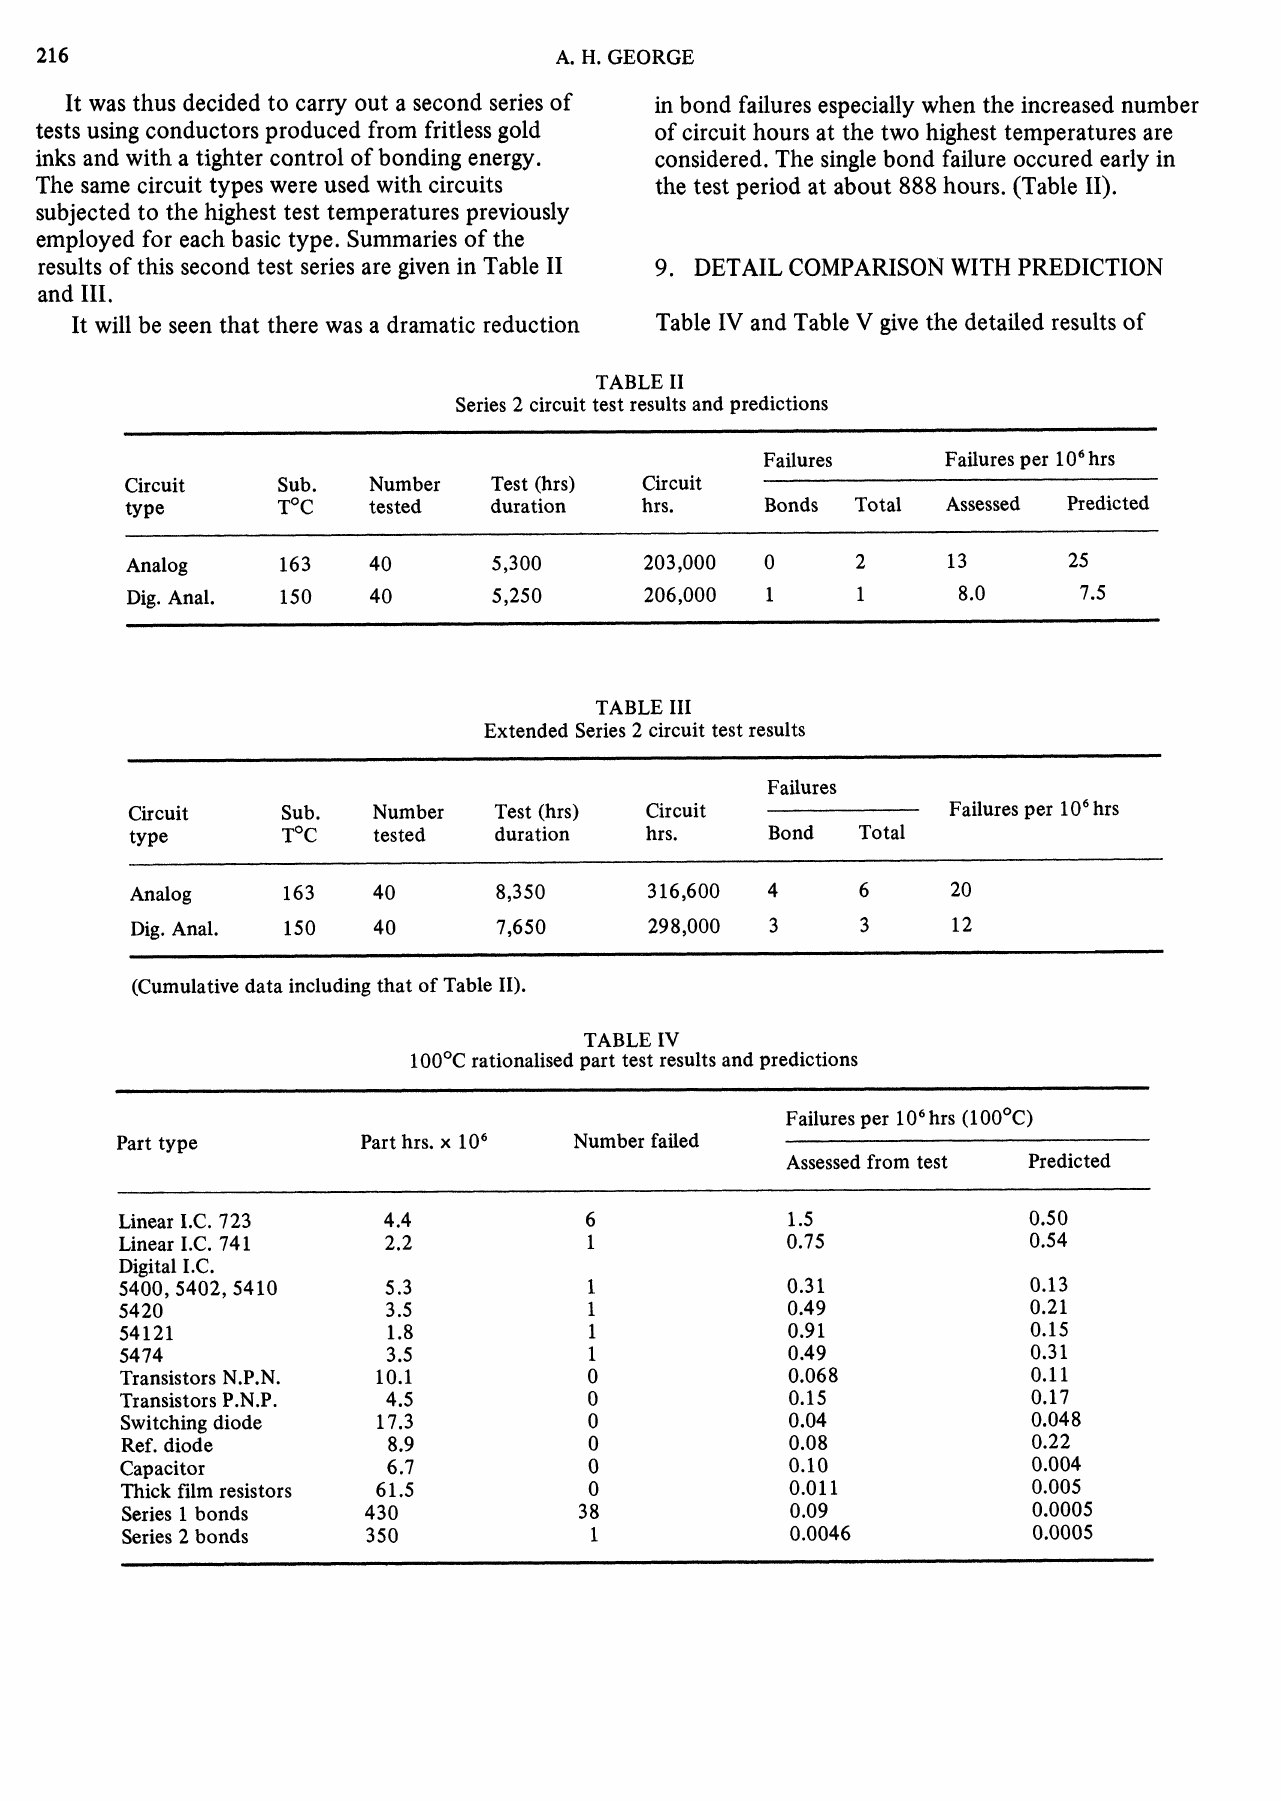
TABLE II Series 2 circuit test results and predictions